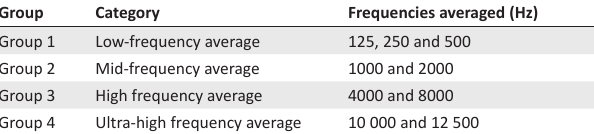
TABLE 2: Averaged low-, mid-, high- and ultra-high frequency groups. Group Category